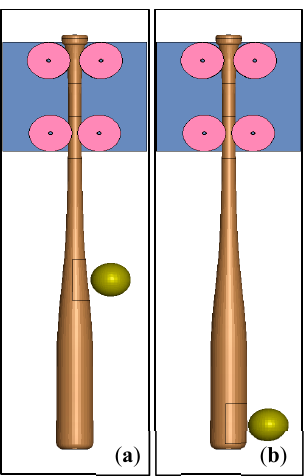
Figure 3. Side-by-side comparison of ( a ) 14.0 in (5.1 cm) model and ( b ) 2.0 in (35.6 cm)